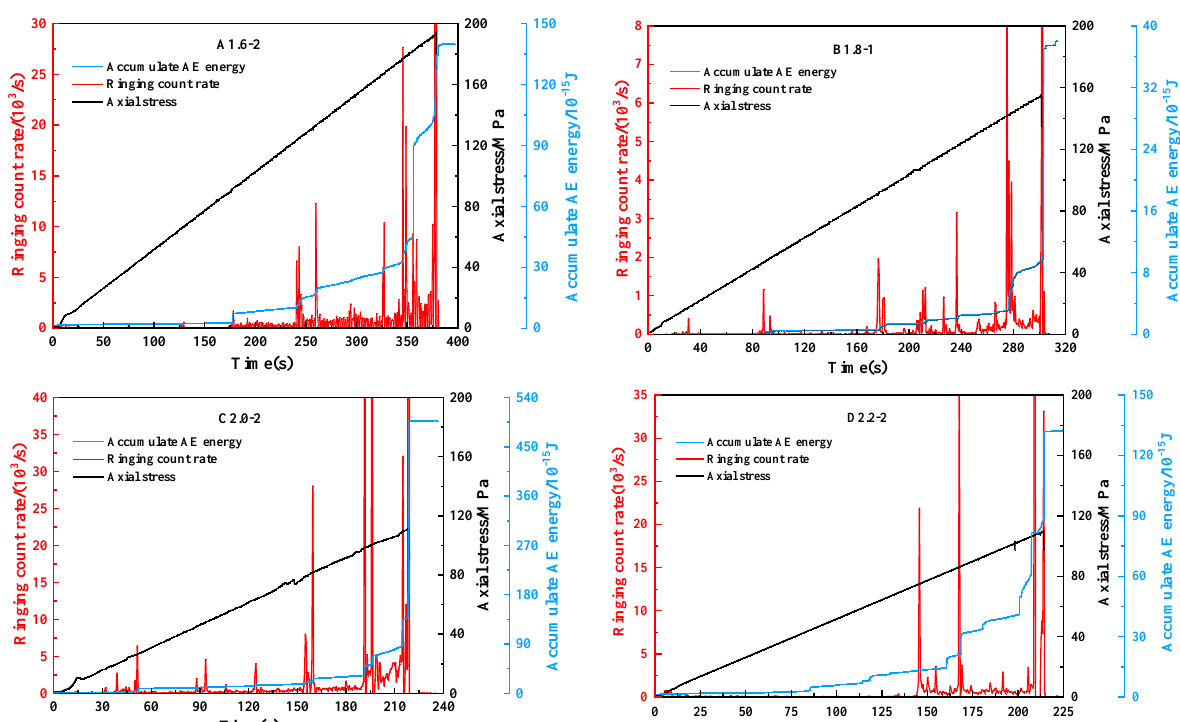
Figure 8. Ringing count rate-axial stress-cumulative energy-time curve of rock samples with different height−diameter ratios.